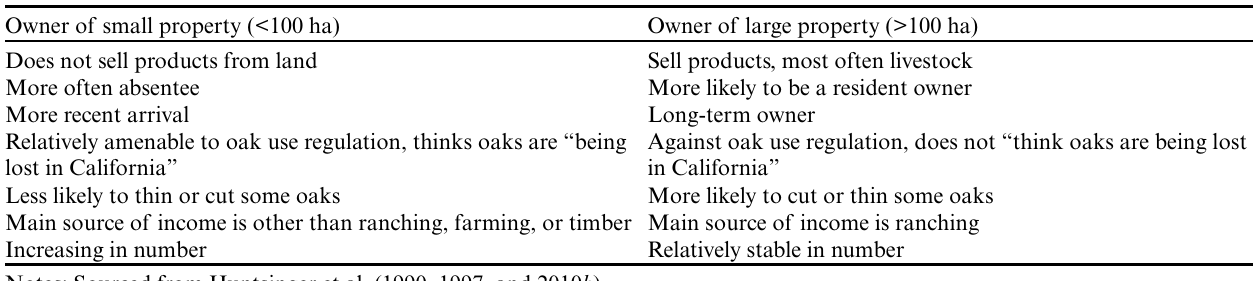
Table 1 . General characteristics of oak woodland landowners as related to property size.